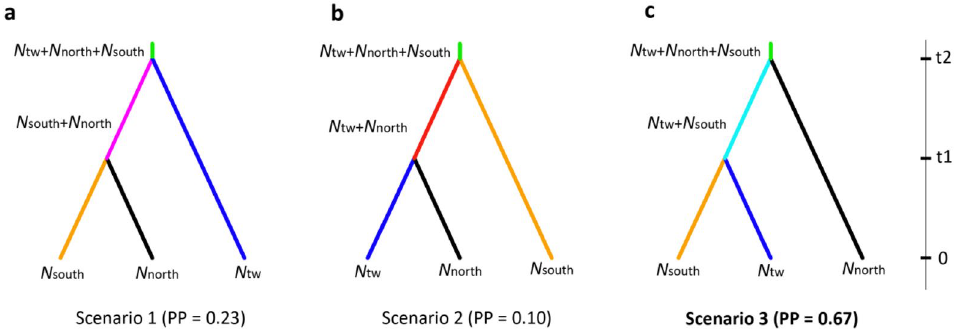
Figure 2. The three divergence scenarios with posteriors probability (PP) among southern, northern and Taiwan clusters of Lindera aggregata ( a – c ). The effective population size of the three clusters is labeled as N south , N north and N tw . t1/t2, divergence times for the depicted event.